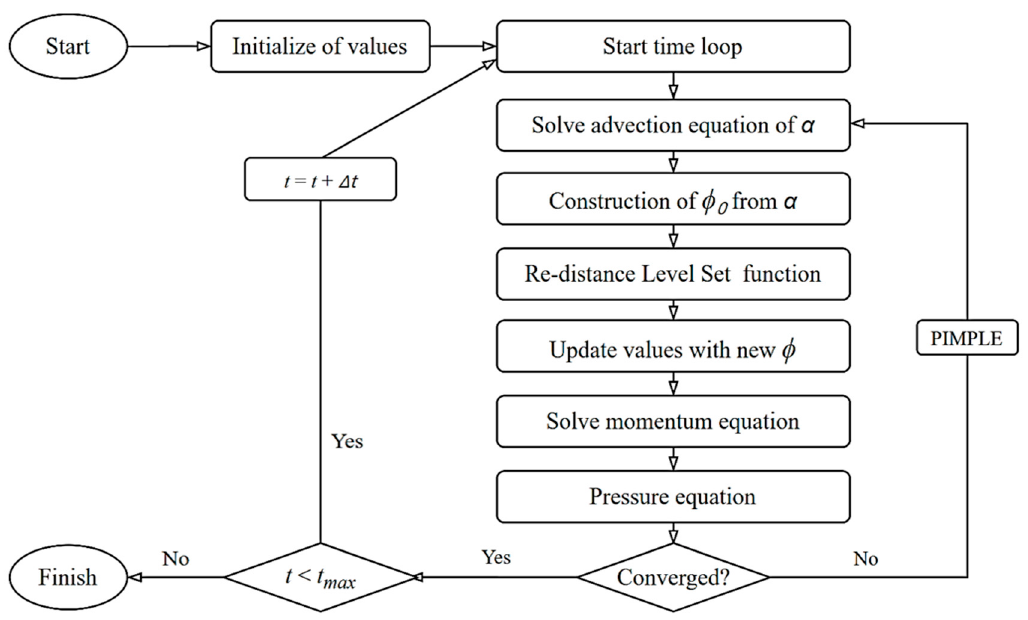
Figure 4. Flow chart of the coupled level-set and volume of fluid (CLSVOF) method.